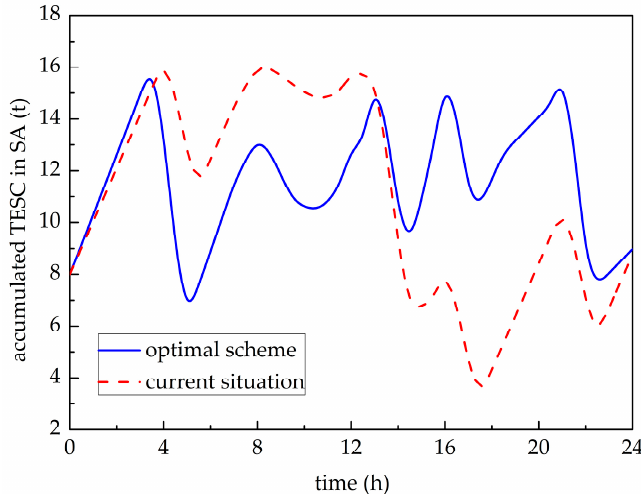
Figure 13. Comparison of accumulated thermal energy storage capacity (TESC) of the optimal and